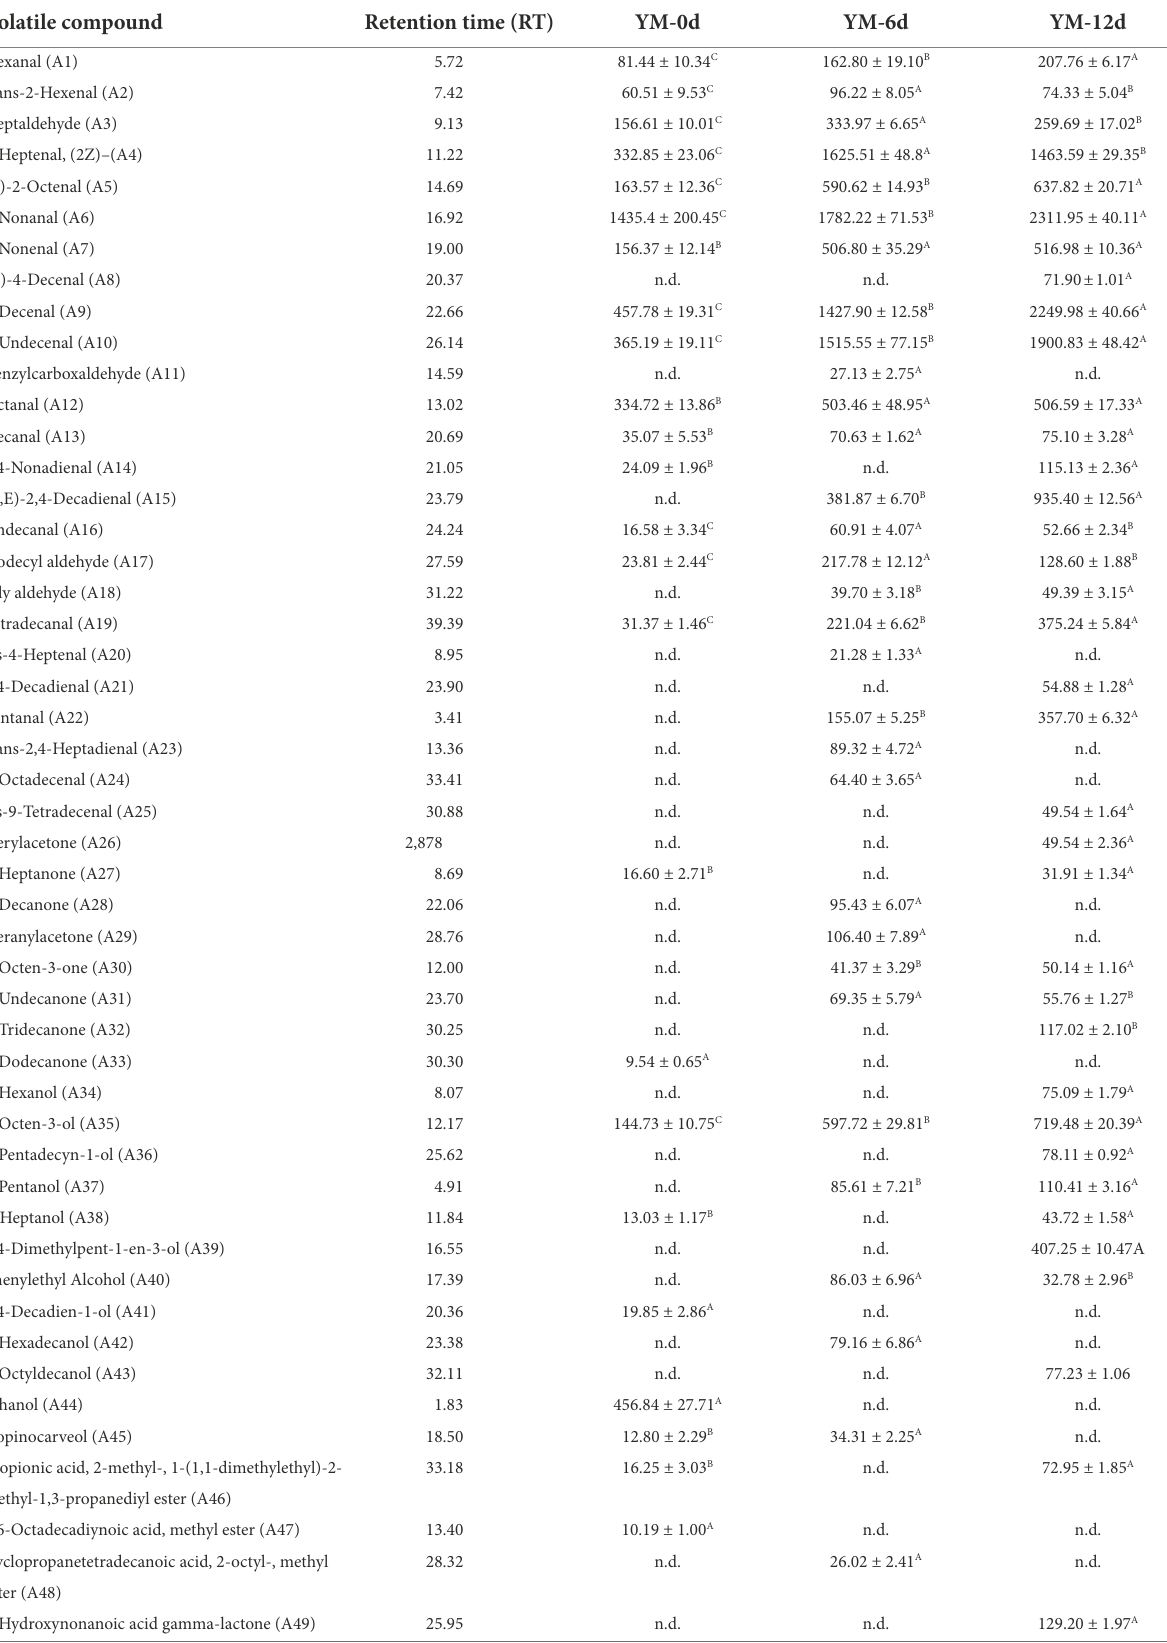
TABLE 2 Changes of volatile flavor compounds during the ripening of fermented